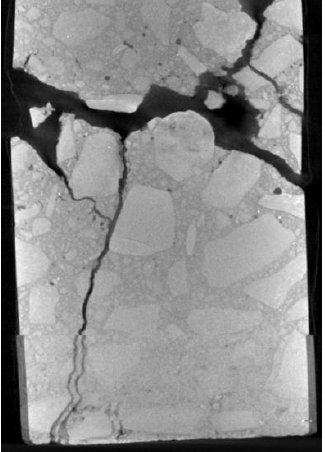
Figure 12. Uneven spatial distribution of coarse and fine aggregates.